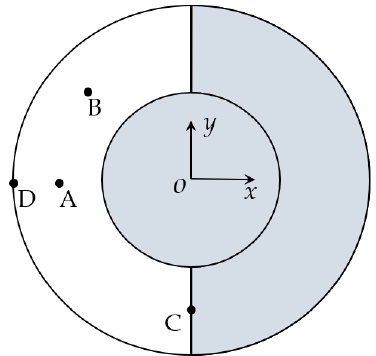
Figure 6. Sketch of the layout of semi-arc air chamber with four selected points A–D.